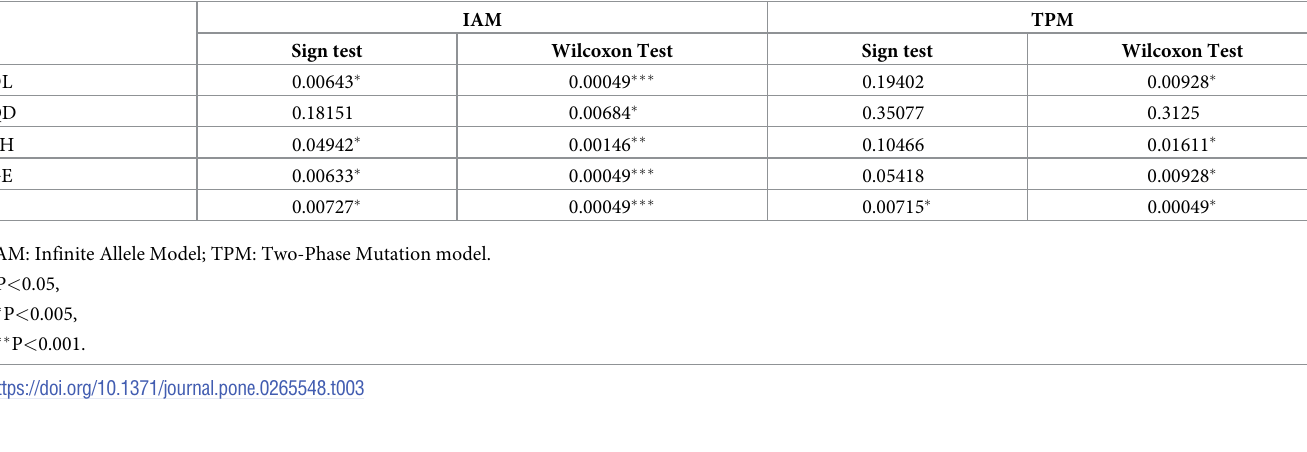
Table 3. Bottleneck effect tests for five populations of T . japonicus